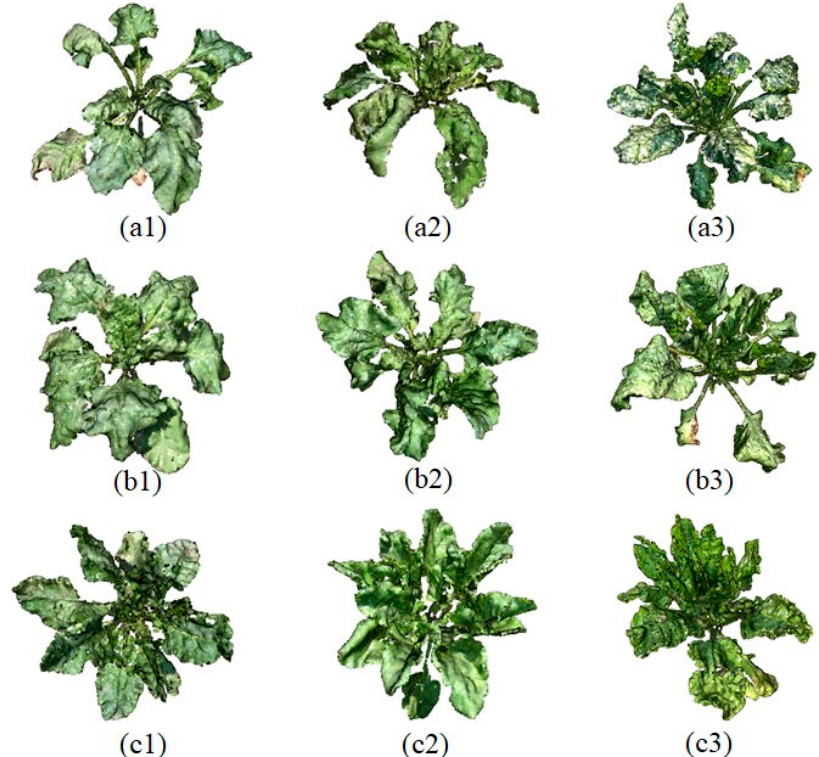
Figure 4. The plant type categories based on the complexity of the leaf layout of the sugar beet plant: simple plant type structure with less overlapping leaves ( a1 – a3 ), ordinary plant type structure with 3–5 leaf overlaps ( b1 – b3 ), belonged to complex plant type structure with severe overlap of leaves ( c1 – c3 ). Both the region-growing algorithm and the MSTVM-based region-growing algorithm were used to segment the point clouds of 30 sugar beets, as shown in Figure 5. The only difference between these two algorithms was the selection criteria of seed points. All other parameter values were the same. Based on visual checks, the MSTVM-based region-growing algorithm yielded more complete leaf point clouds as compared to the region-growing algorithm. (Figure